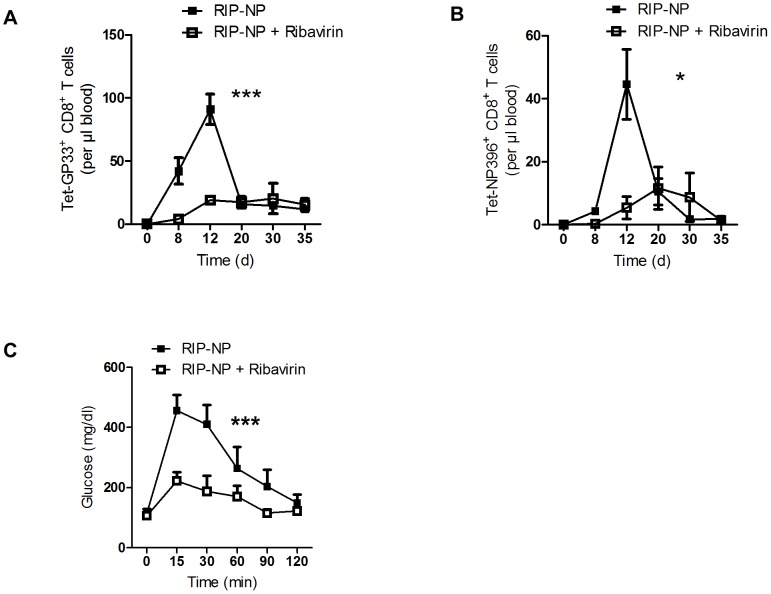
Ribavirin blunts auto-reactivity in RIP-NP diabetes model.RIP-NP mice were treated intraperitoneally with Ribavirin (5 mg daily), starting on day −3. On day 0, mice were infected with 200 PFU of LCMV-WE. (A) Numbers of virus-specific Tet-GP33+ CD8+ T cells were determined by tetramer staining and flow cytometry (n = 5–6). (B) Numbers of autoreactive Tet-NP396+ CD8+ T cells were determined by tetramer staining and flow cytometry (n = 5–6). (C) On day 50 glucose tolerance test was performed (n = 5–6). * P<0.05 and *** P<0.001 two-way analysis of variance (ANOVA).